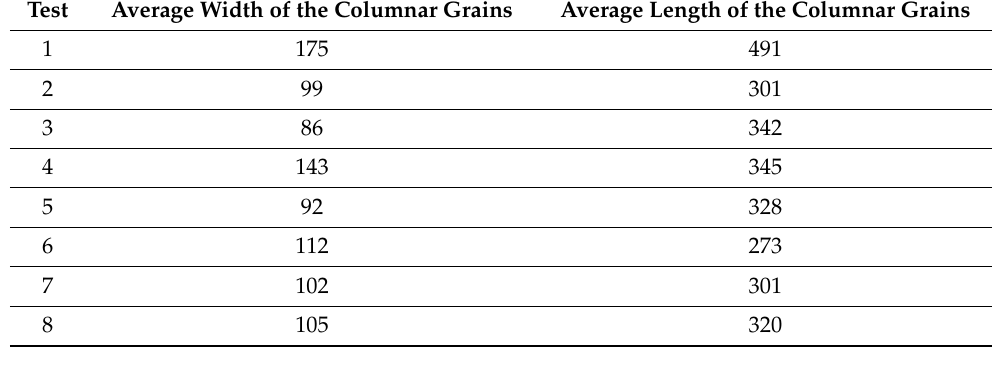
Table 5. Measured dimension of columnar grain in the bottom part of the welded joints ( µ m).